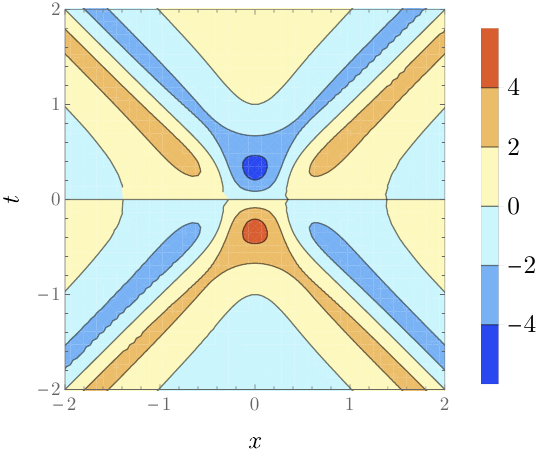
Figure 3 . First order term in (cid:27) (as in (2.9)) of the energy density E ( t; x ) = T ++ ( t + x )+ T (cid:0)(cid:0) ( t (cid:0) x ) for example 1 with a (cid:6) = c (cid:6) = 1. This picture can be interpreted in terms of two wavepackets, one moving to the left and one moving to the right at the speed of